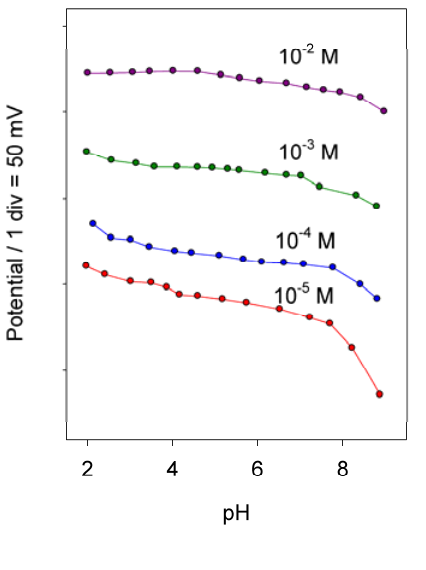
Figure 4. Influence of pH on the electrode potential for different sulpiride concentrations